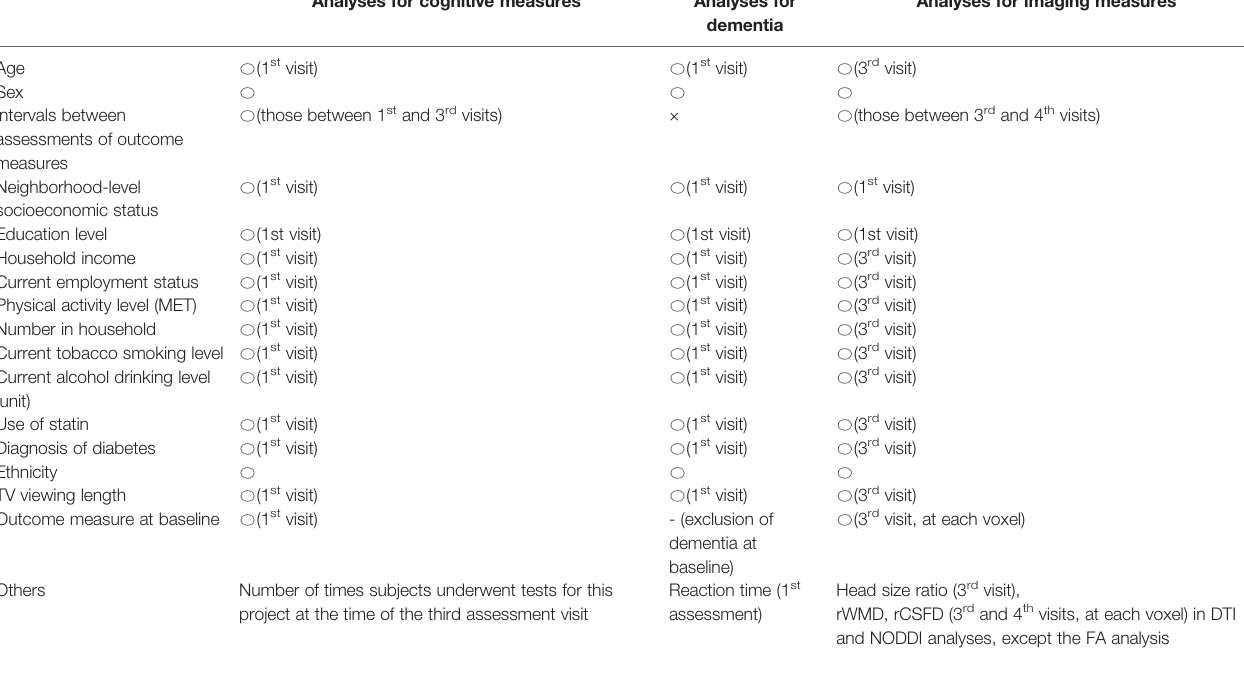
TABLE 1 | Sets of covariates and how they are used in each analysis. Analyses for cognitive measures Analyses for